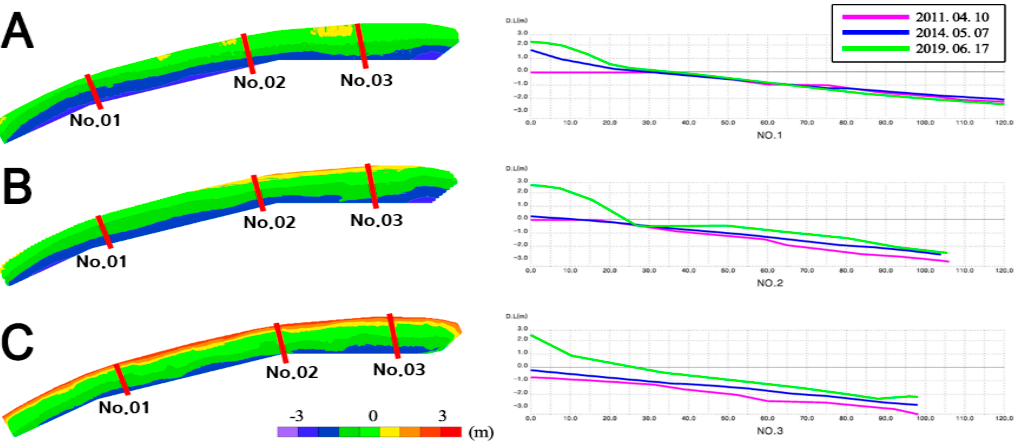
Figure 2. Surveyed bathymetry and beach transect along Haeundae Beach ( A -2011, B - 2014, C -2019).